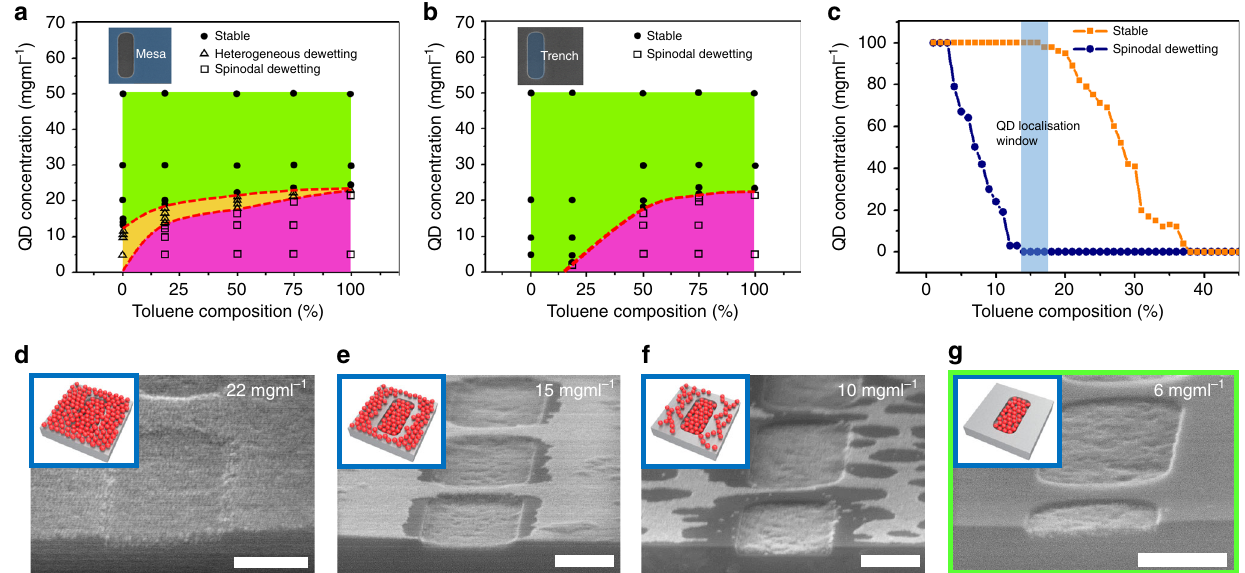
Fig. 2 Domain speci fi c patterning of QD fi lms by controlled dewetting mechanism. QD concentration and solvent composition dependent stability diagram of dried QD fi lm are plotted separately for mesa ( a ) and trench ( b ) domains. The symbols ● , △ and □ indicate conformal QD fi lm, heterogeneous dewetting near the mesa edge, and spinodal dewetting throughout the domains, respectively. c The domain coverage of QD fi lm on mesa and trench area as a function of change in solvent composition. The blue shadow indicates experimental window of solvent composition in which the contrast in domain coverage between mesa and trench area is the greatest. d – g Tilted SEM images (respective schematics in the insets) that show the change in dewetting behavior of dried QD fi lms as QD concentration decreases (constant toluene composition at 13%). Scale bars denote 300